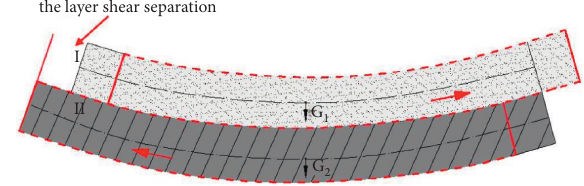
Figure 4: The layer shear